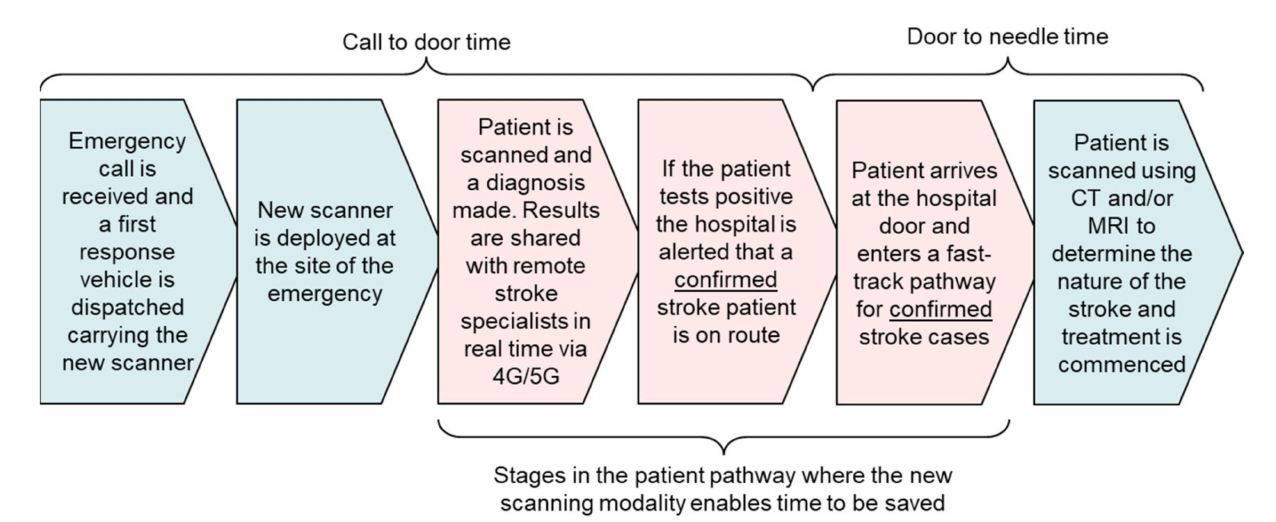
Figure 1. Reducing delay in the patient pathway for